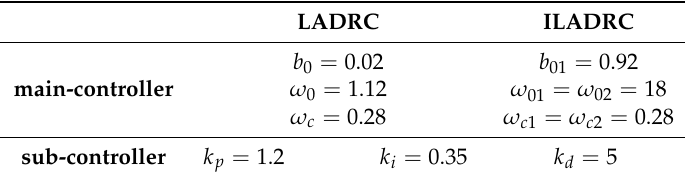
Table 1. Parameters of LADRC and